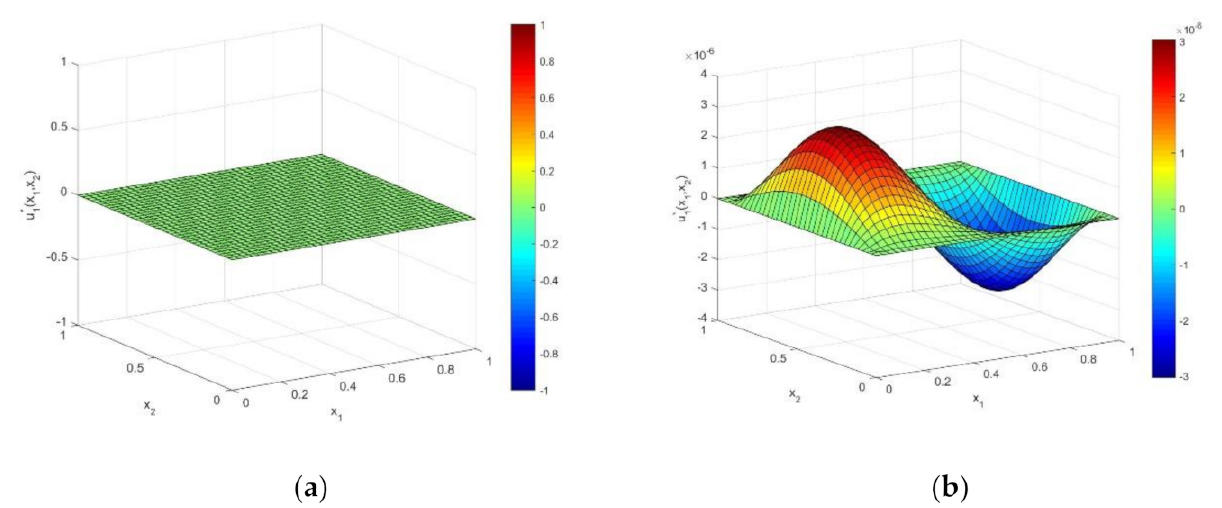
Figure 5. Three-dimensional map of in-plane deformations for ( a ) homogeneous plate and ( b ) transversally graded FGM plate with gradation parameters ζ = 1, p =